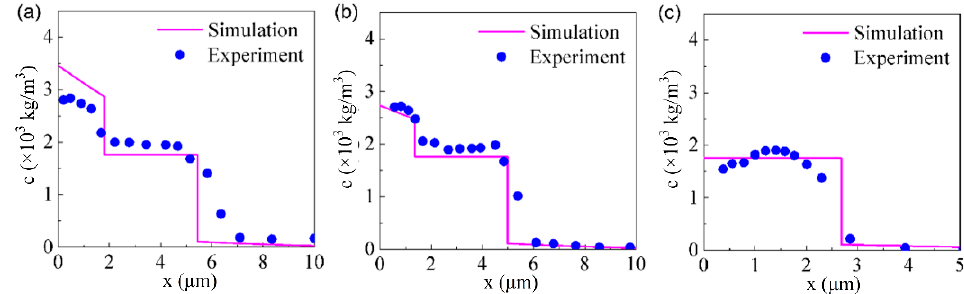
Figure 7. Comparison of the simulation and experimental results of Ti atoms along the cross-sectional profile after thermal diffusion at 650 ℃ for 4 h: ( a ) F1, ( b ) F2, ( c ) F3.